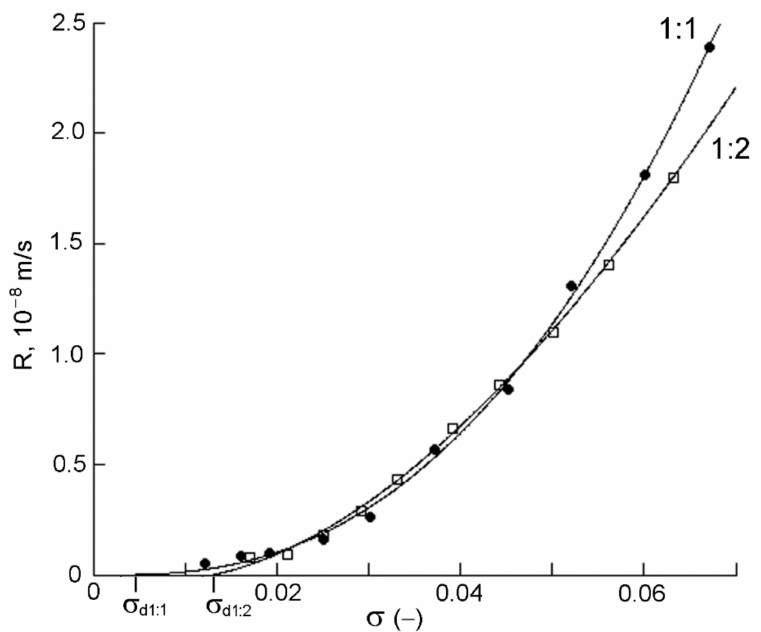
Figure 3. Normal growth rate of growth hillocks on the (110) face in 1:1 and 1:2 solutions as a function of supersaturation. The data for R in 1:1 and 1:2 solutions are fitted by Equations (12) and (13), respectively (the values of fitting parameters are given in Section 4.5. Instrumental error of the R measurements is within the size of the experimental